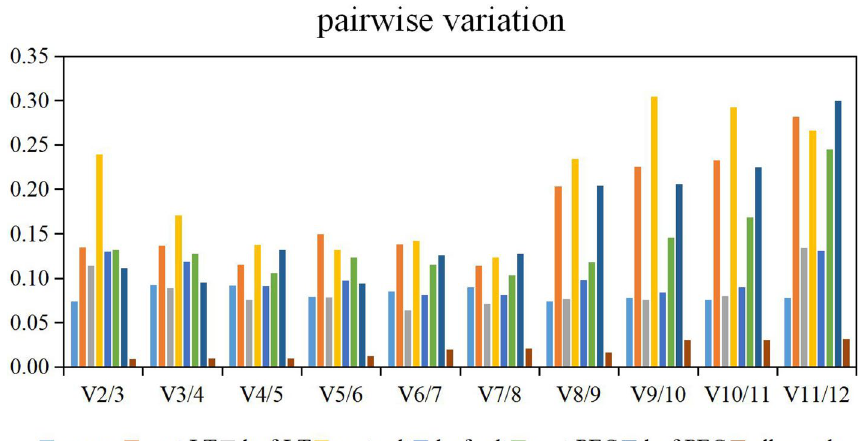
Figure 4. Pairwise V values of 12 candidate reference genes from Caucasian clover, as calculated by geNorm. The different treatments are marked with square frames of different colors. LT indicates the low-temperature treatment (4 °C), and PEG indicates the 10% PEG-6000 treatment; all samples of the four treatments were considered jointly as all samples, and organs were evaluated under normal conditions, as described below.